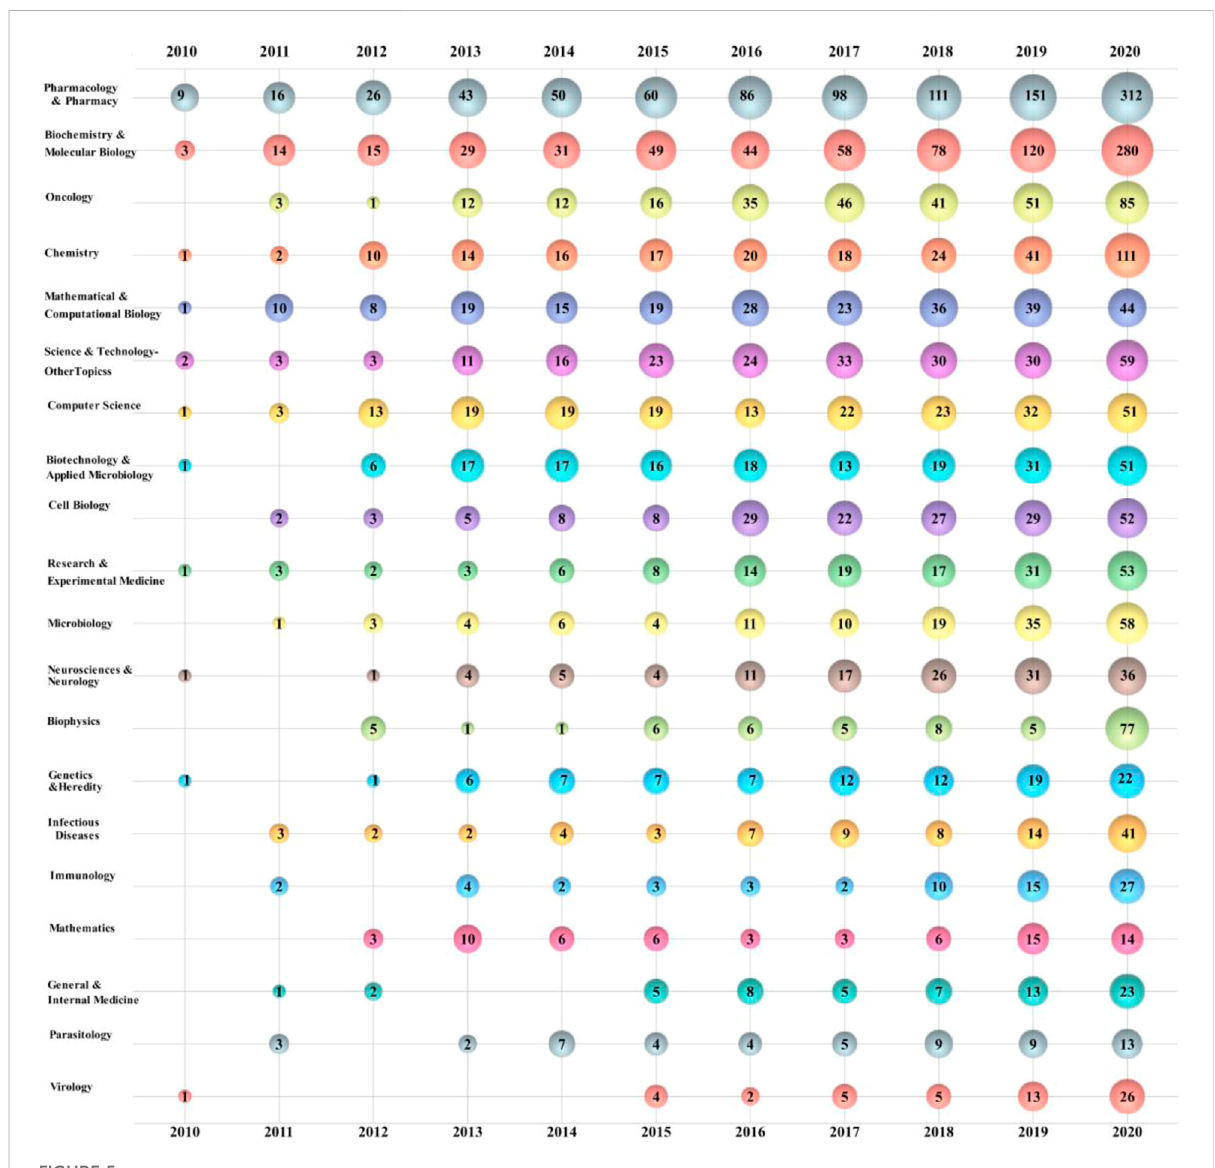
FIGURE 5 Bubble chart of the top 20 drug repositioning research areas by